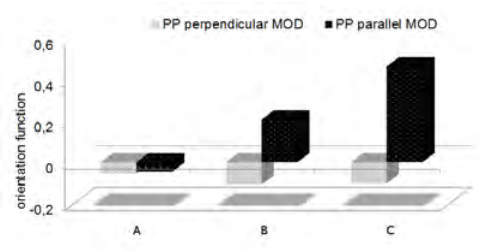
Figure 5. Orientation function calculated from Raman spectra and DSC measurements for A non- deformed, B deformed and C highly deformed polypropylene (PP).